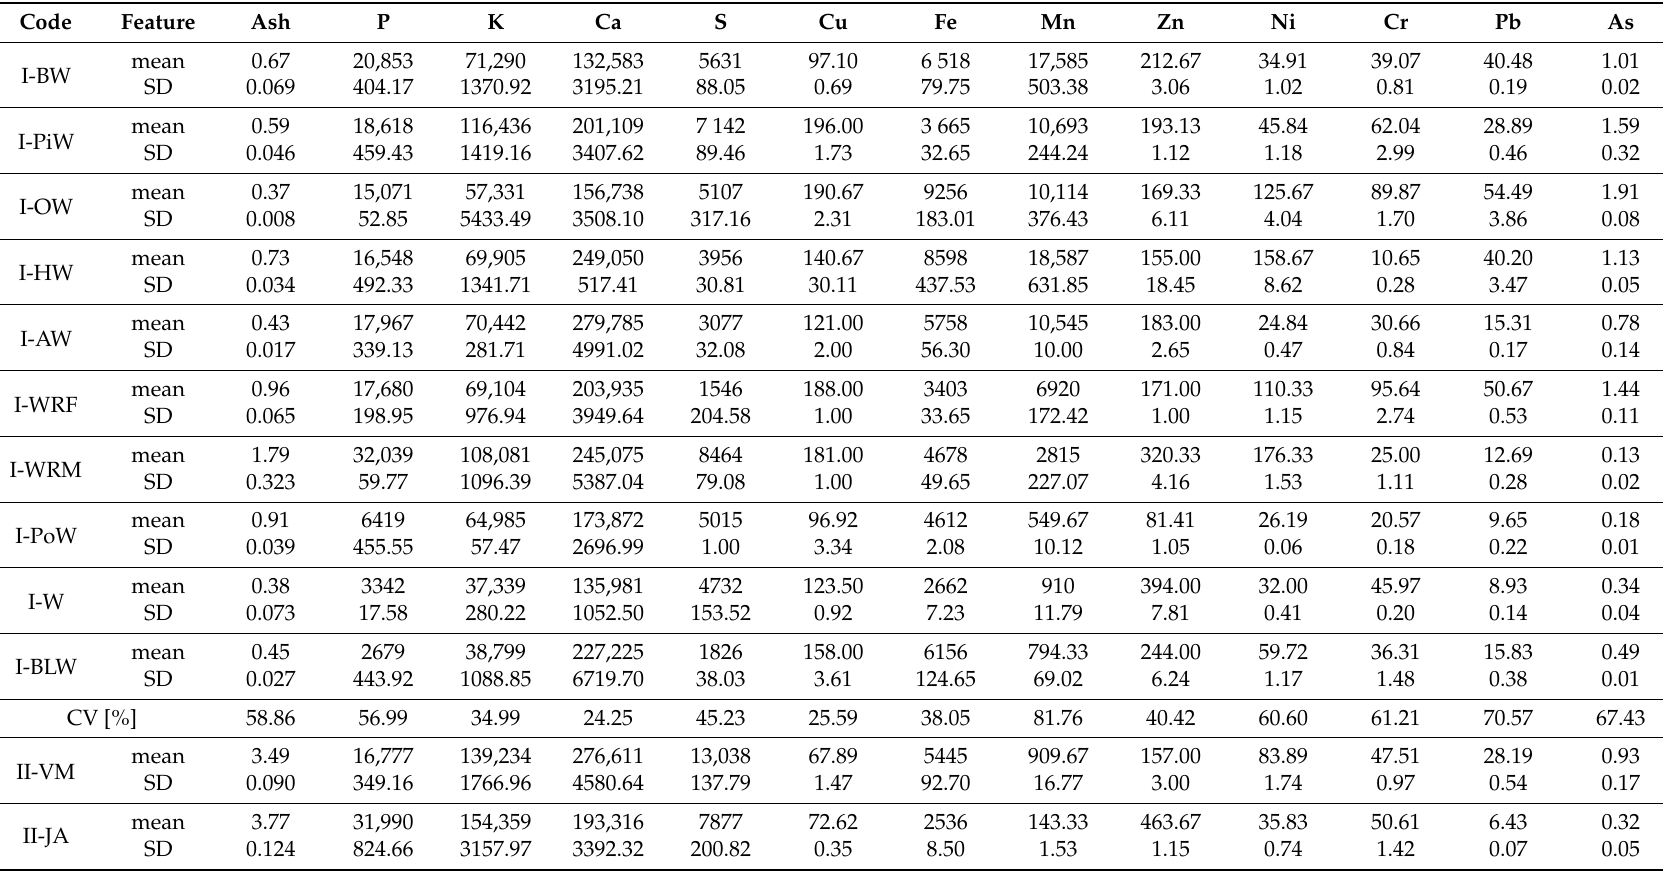
Table 2. Ash content in the biomass [%] and chemical composition of the ashes tested